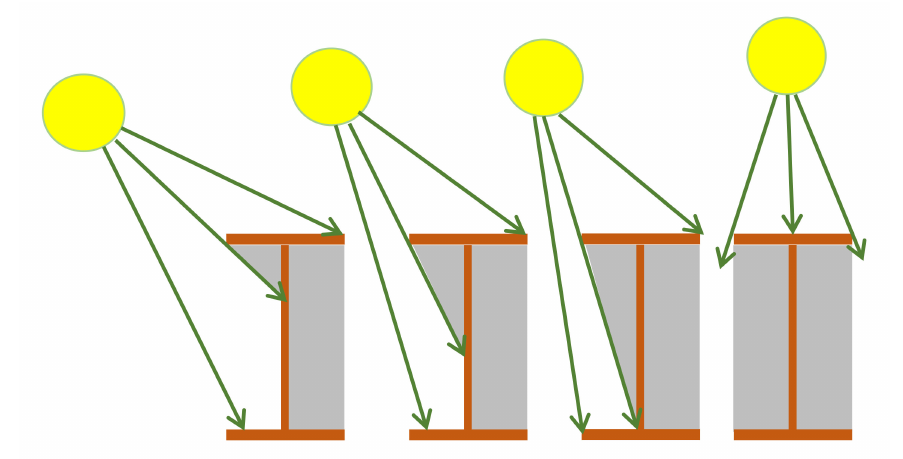
Figure 1. Web shadowing from top